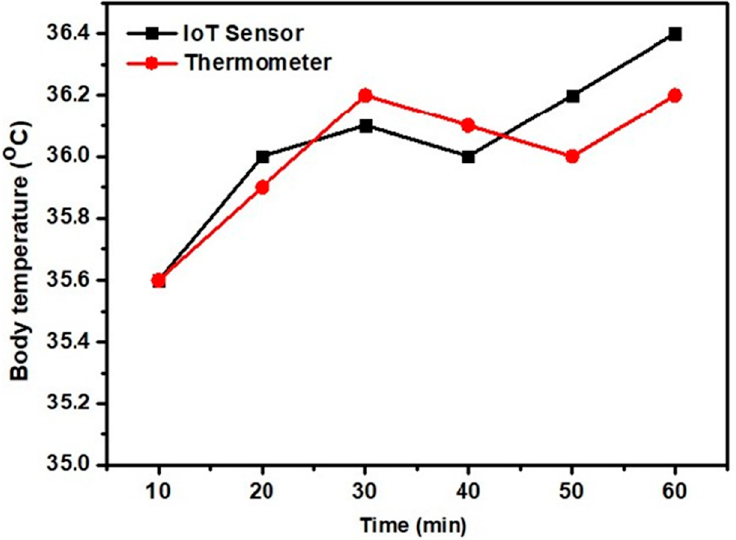
Figure 7. Comparison of the MLX 90614 sensor and the thermometer.